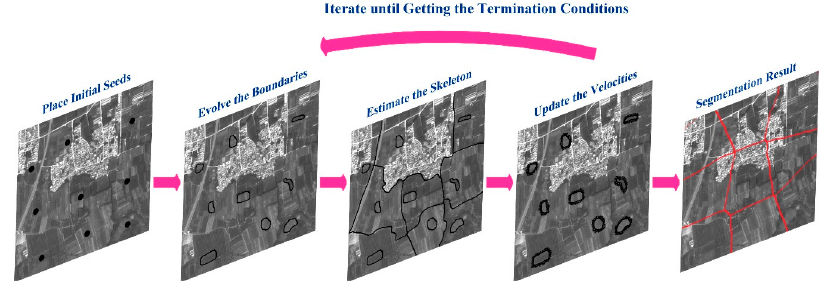
Figure 2. Segmentation steps and the result.